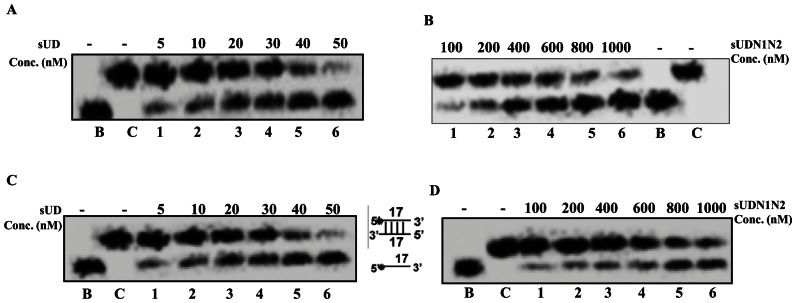
Unwinding activity analysis of sUD and sUDN1N2 with different substrates.The structure of the substrate used is shown. Asterisk (*) denotes the 32P-labeled end. A. Lanes 1–6 are the reactions with increasing concentration of sUD. B. Lanes 1–6 are the reactions with increasing concentration of sUDN1N2. C. Lanes 1–6 are the reactions with increasing concentration of sUD. D. Lanes 1–6 are the reactions with increasing concentration of sUDN1N2. In panel A–D, lane C is reaction without enzyme and lane B is heat treated substrate.